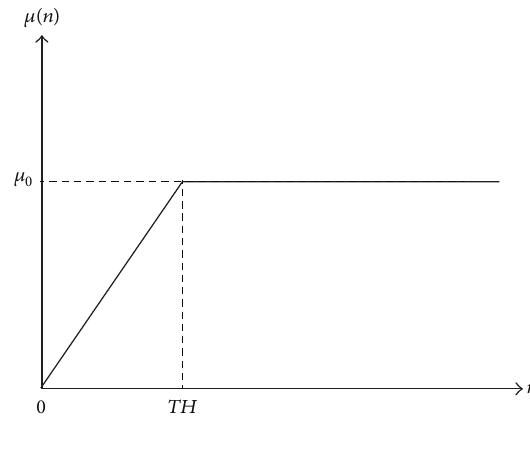
Figure 1: The playout rate function of linear slowdown playout system (smoother) [2,